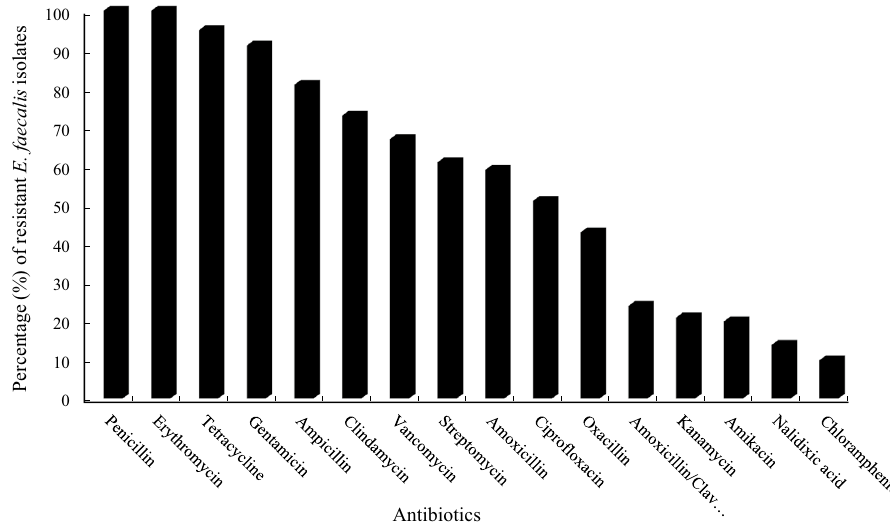
Figure 2. Percentage of antimicrobial resistance of fifteen E. faecalis strains to different antibiotics. Penicillin (PEN), Erythromycin (ERY), Tetracycline (TET), Gentamicin (GEN), Ampicillin (AMP), Clindamycin (CLI), Vancomycin (VAN), Streptomycin (STP), Amoxicillin (AMX), Ciprofloxacin (CIP), Oxacillin (OXA), Amoxicillin/Clavulanic acid (AMC), Kanamycin (KAN), Amikacin (AMK), Nalidixic acid (NAL), and Chloramphenicol (CHL).